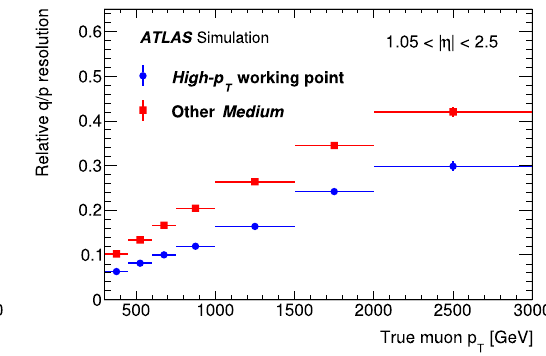
Fig. 2 The q / p resolution as a function of the transverse momentum of muons in the barrel (left) and endcaps (right), shown separately for muons passing the High - p T WP requirements and for the rest of the